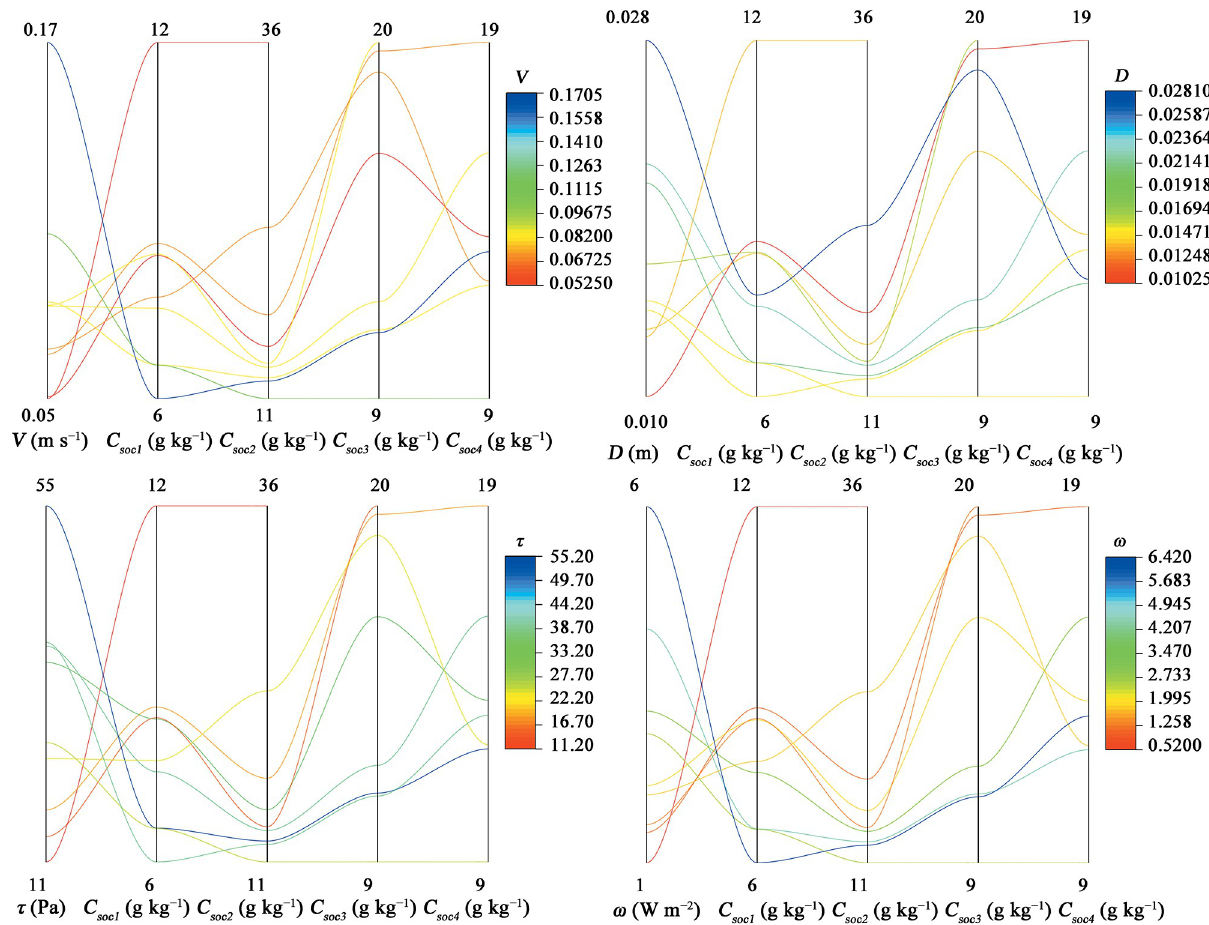
Fig 8. Effect of hydraulic characteristics (e.g., flow velocity, runoff depth, shear stress, and stream power) on OC distribution in sediments ( C soc1 : The SOC concentration in < 0.05 mm sediment particles; C concentration in 0.25–2 mm sediment particles; C soc4 : The SOC concentration in > 2 mm sediment particles).